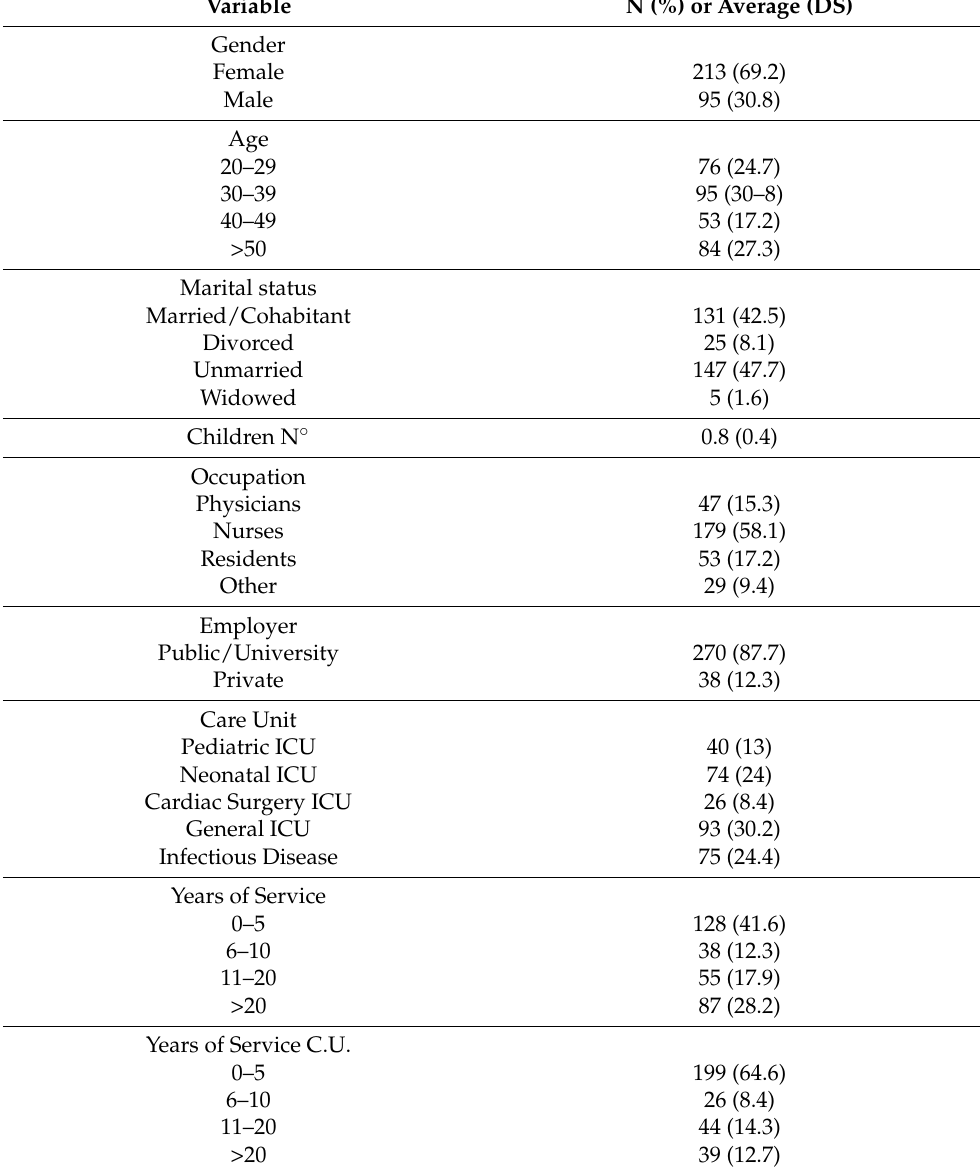
Table 1. Sample descriptive